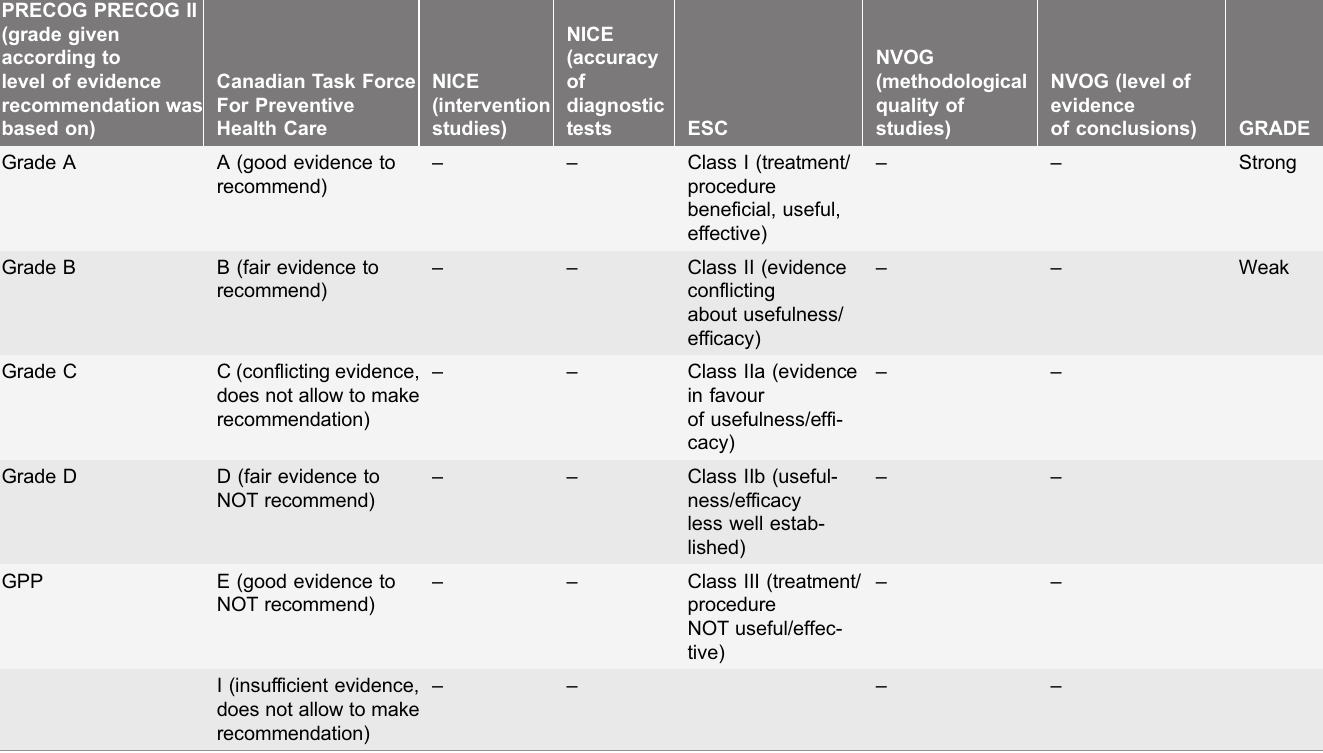
Table 3. Grading systems for assessing the strength of